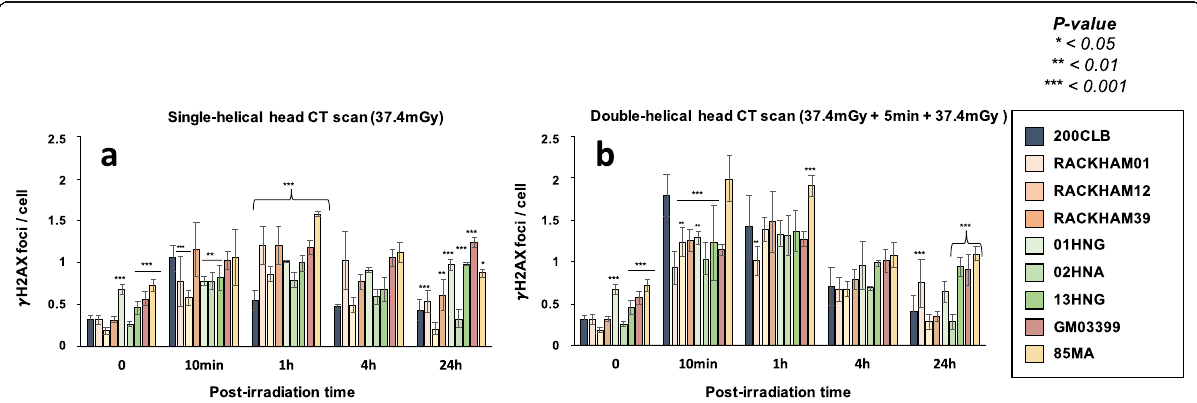
Fig. 3 γ H2AX foci in fibroblasts after single- and double-helical CT scan exposure. a Kinetics of γ H2AX foci in fibroblasts after a single helical head CT scan, or ( b ) a double-helical head CT scan at the indicated times after exposure (t0 = non irradiated). Each data represents the mean ± SEM of 3 independent experiments. The asterisks shown at the non-irradiated conditions and at 10 min and 1 h post-irradiation times correspond to a statistically significant difference with the radioresistant control 200CLB ( p < 0.05). The asterisks shown at 24 h post-irradiation correspond to a statistically significant difference with the non-irradiated conditions for the same cell lines. CT Computed tomography, γ H2AX Phosphorylated forms of the H2AX histone variant, SEM Standard error of the